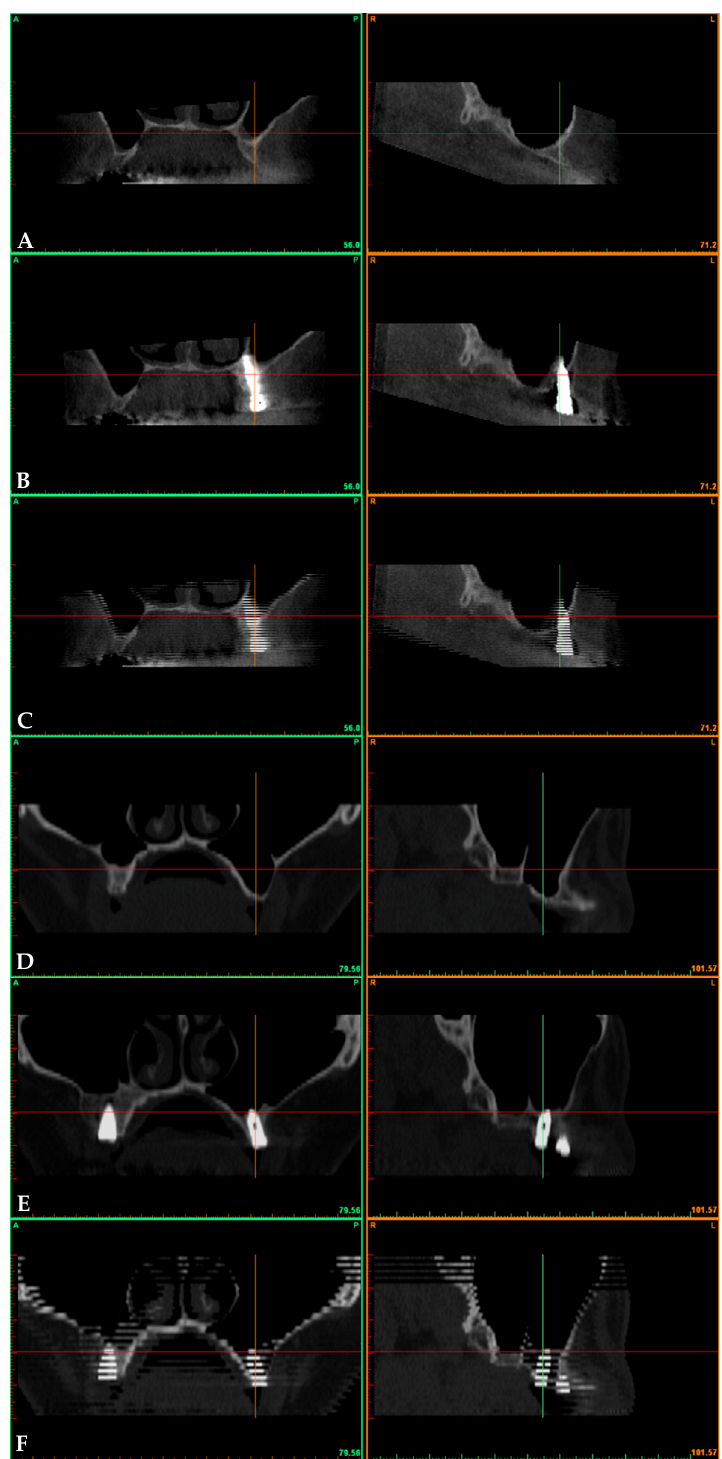
Figure 3. Fontal and lateral views of an augmented sinus by a backward displacement technique of the anterior wall: ( A ) preoperative; ( B ) postoperative; ( C ) fused files. Fontal and lateral views of an augmented sinus by lifting and grafting with a particulate bone substitute with a lateral window approach: ( D ) preoperative; ( E ) postoperative; ( F ) fused files.